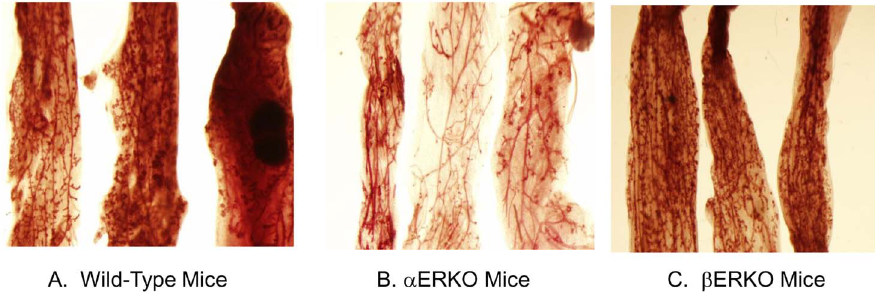
Figure 2. Effects of pretreatment with EGF and progesterone on the mammary gland development in MMOC. WT, a ERKO and b ERKO mice were treated with 25 ng EGF and 1 mg Progesterone for 5 days s.c. The glands were dissected and cultured in serum free Weymouth’s medium for 10 days in the presence of insulin (1 m g/ml), prolactin (5 m g/ml), aldosterone (1 m g/ml) and hydrocortisone (1 m g/ml). Results show that mice pretreated with EGF and P can replace pretreatment with Estradiol and progesterone for ERKO mice. A. WT, B. a ERKO, C. b ERKO Mice.